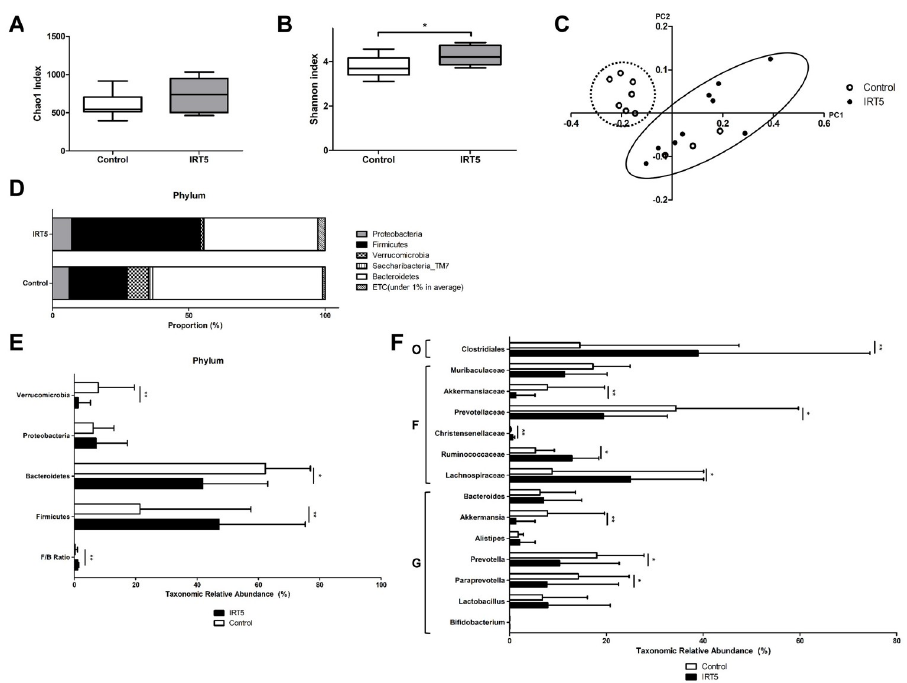
Fig 3. Intestinal microbime compositional changes, alpha and beta diversity. There was no difference in species richness by Chao1 index (p > 0.05) (A). However, significant increase in species diversity by Shannon index was observed in IRT5 group (p = 0.041) (B). Beta diversity of genus by UniFrac principle coordinates analysis showed significant distance between groups (p = 0.001) (C). Compositional differences in phylum between groups were observed, such as Verrucomicrobia (p = 0.009), Bacteroidetes (p = 0.011), Firmicutes (p = 0.009) (D and E). The Firmicutes / Bacteroidetes (F/B) ratio significantly increased in the IRT5 group (p = 0.009) (E). In class, IRT5 group showed increased Clostridiales (p = 0.009) (F). In family, IRT5 group had decreased Akkermansiaceae (p = 0.009) and Prevotellaceae (p = 0.014), and increased Christensenellaceae (p = 0.001), Ruminococcaceae (p = 0.018), Lachnospiraceae (p = 0.018) (F). In genus, IRT5 group revealed to have decreased Akkermansia (p = 0.009), Prevotella (p = 0.041) and Paraprevotella (p = 0.041) (F). There was no significant difference in Lactobacillus and Bifidobacterium between groups (F). O: order, F: family, G: genus. Statistical analysis with error bars indicating the minimum and maximum data points by Wilcoxon rank-sum test: � p < 0.05, �� p < 0.01. relative abundance average of at least 5% or above ( Lactobacillus helveticus group was included despite low taxonomic relative abundance because it was the only Lactobacillus that had